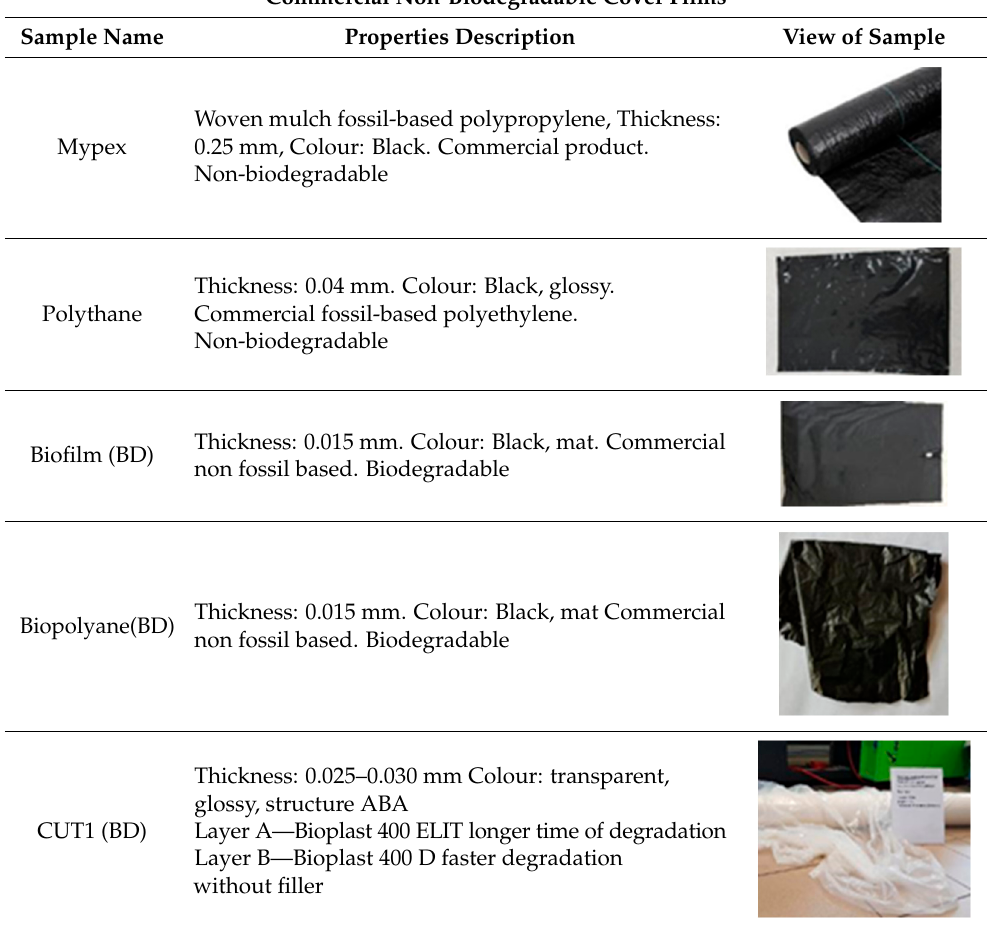
Table 1. Commercial, biodegradable and non-biodegradable mulching films used in the research.